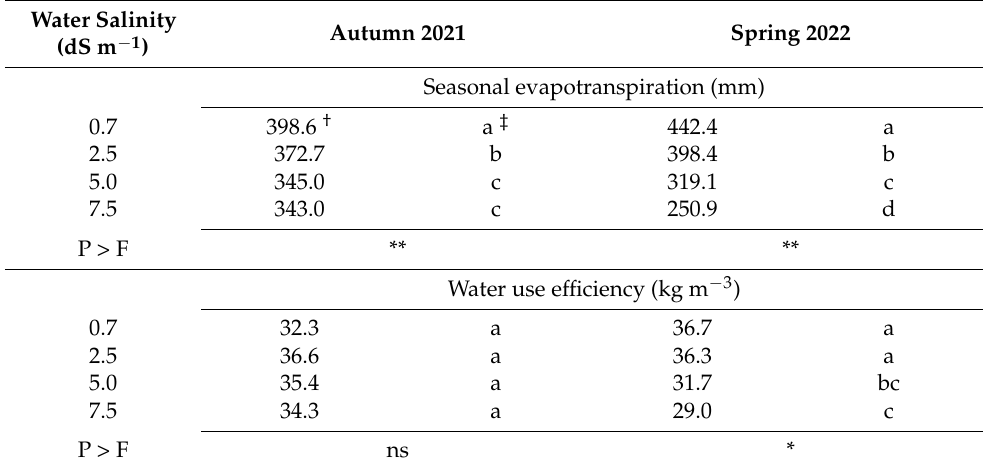
Table 3. The effect of irrigation water salinity on seasonal evapotranspiration and water use efficiency. Water Salinity Autumn 2021 Spring (dS m − 1 )